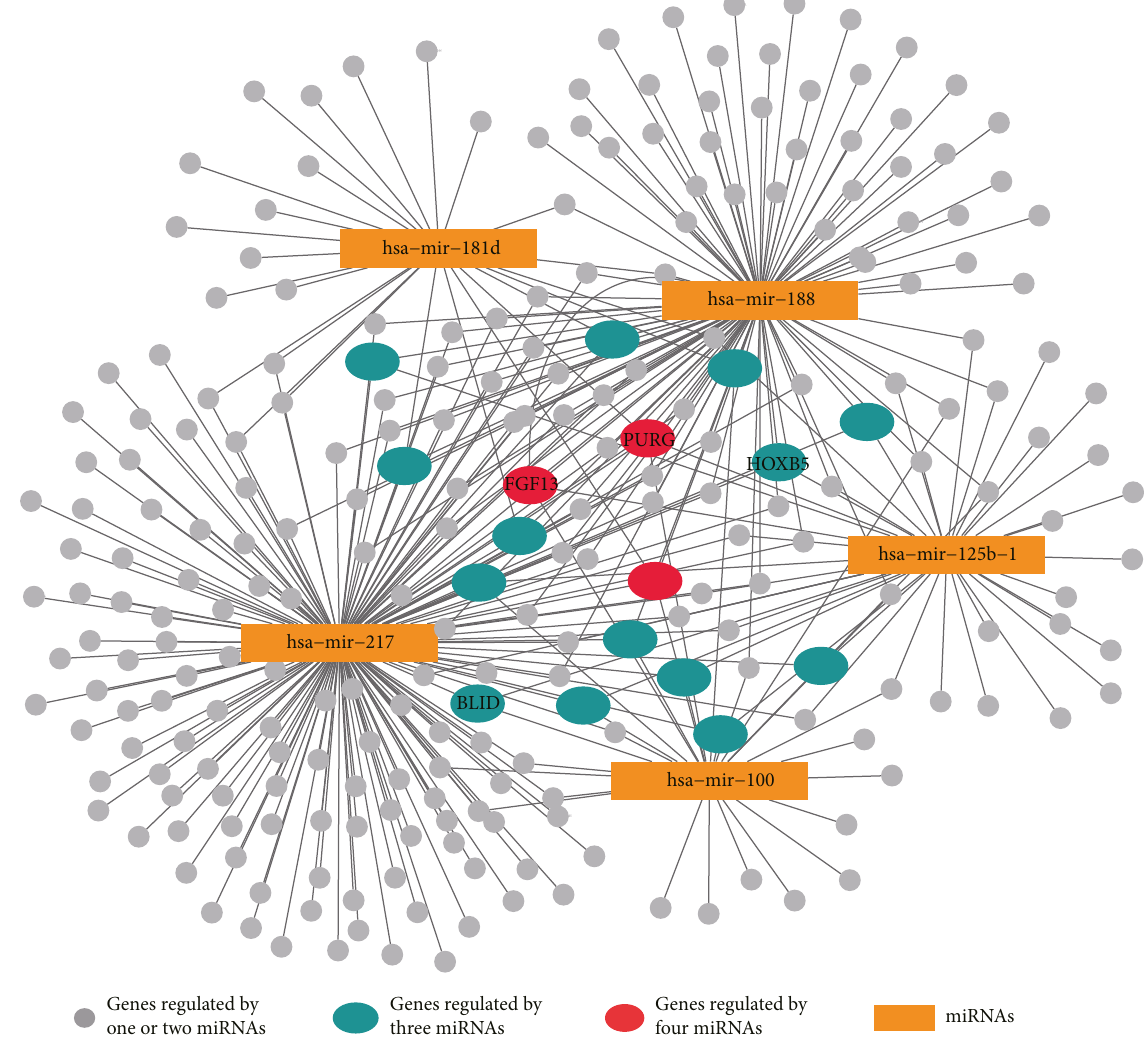
Figure 2: The miRNA-mRNA interaction subnetwork in AML. The fi ve miRNAs in the network were reported to be associated with AML. In the fi gure, 14 mRNAs (cyan dots) and 3 mRNAs (red dots) were predicted to be connected with three and four miRNAs, respectively. The genes correlated with cancers were marked with their gene